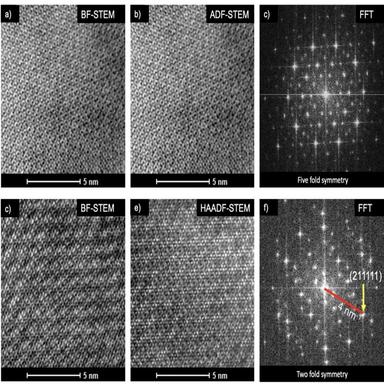
(a and b) Atomic resolution BF-STEM and ADF-STEM image of a unique quasicrystal along a fivefold symmetry axis. (c) Fourier transformation of ADF-STEM image in (b). (d and e) Atomic resolution BF-STEM and HAADF-STEM image of a quasicrystal along twofold symmetrical zone axis. (f) Fourier transformation of HAADF-STEM image from (e). The distance from the diffracted spot with (211111) indices to the non-diffracted beam at the centre is denoted by the line in (f) which was measured as 4 nm−1 .